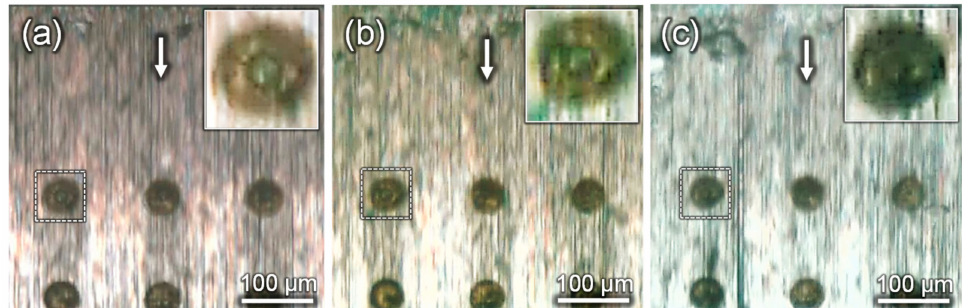
Figure 10. Captured images from in-situ observations at a punch stroke of 1.5 mm in bending with the ironing process with a 50 µ m-dimple textured die using lubricants with di ff erent viscosities of ( a ) 4.51 mm / s 2 , ( b ) 2.53 mm / s 2 , and ( c ) 1.27 mm 2 /